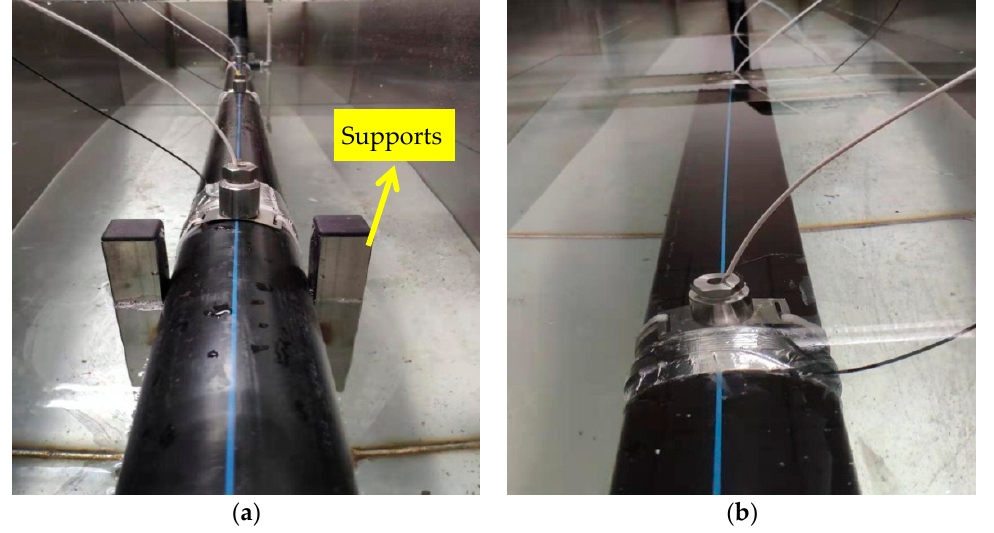
Figure 7. Test rig: ( a ) on supports; ( b ) submerged.